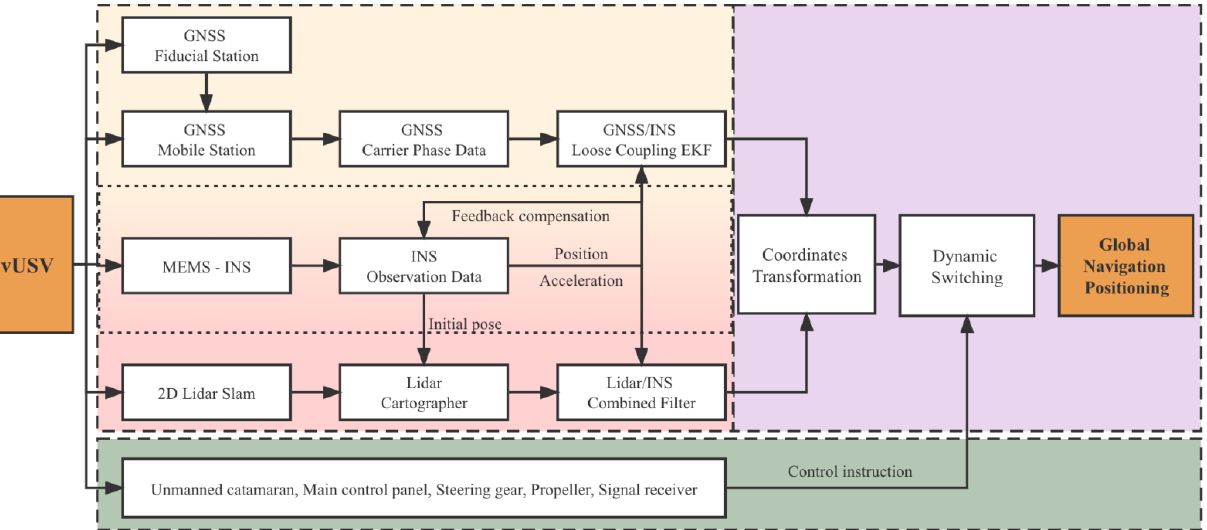
Figure 1. NavUSV integrated navigation method roadmap. Different colors represent different sub- sections.